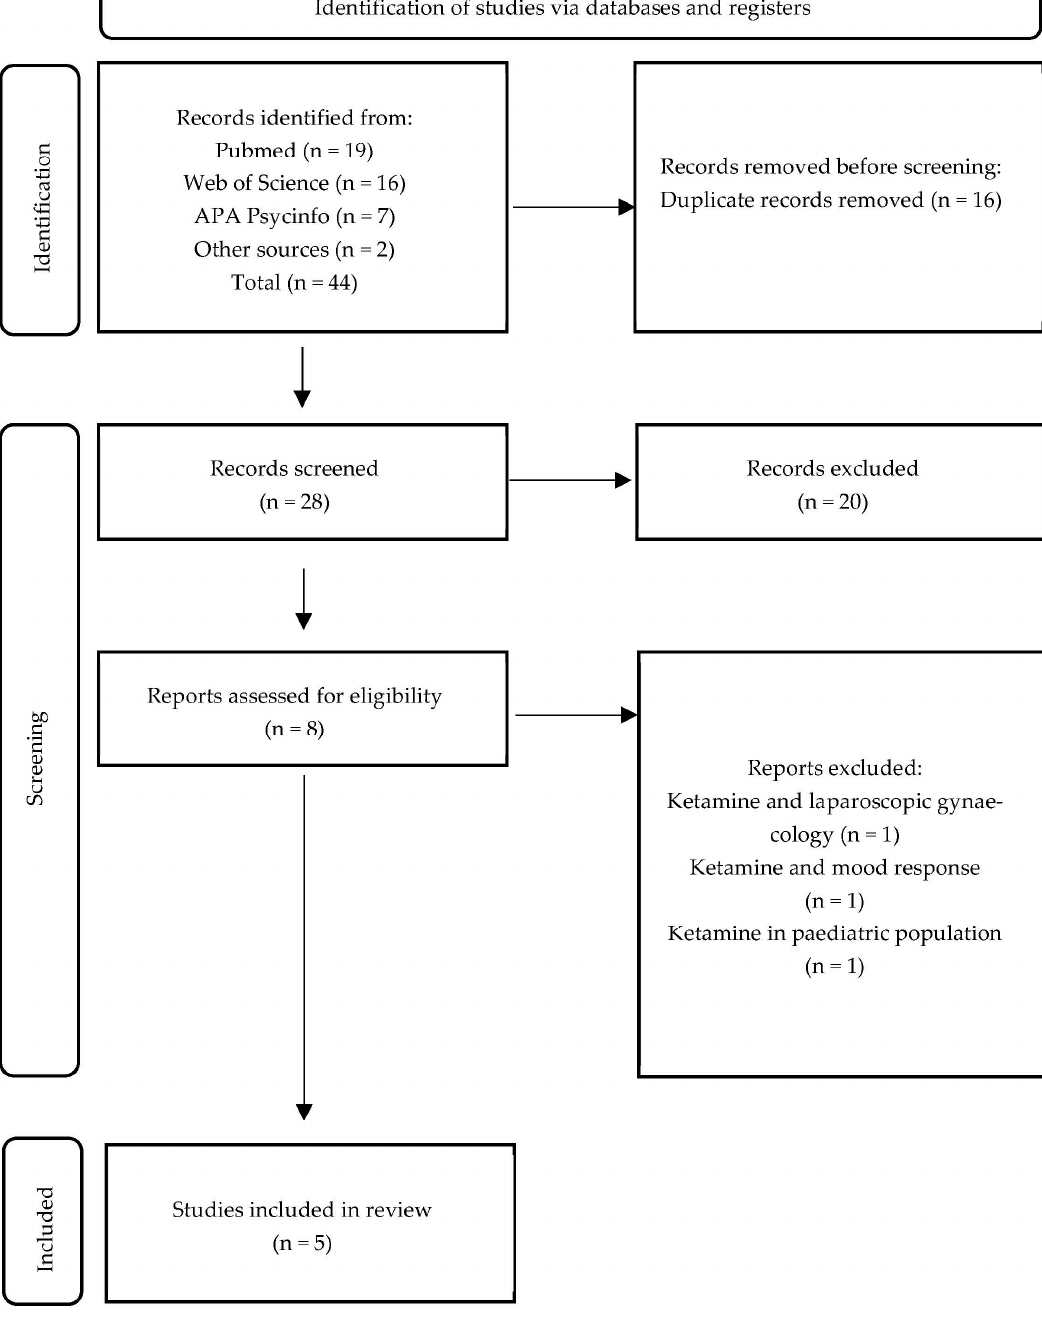
Figure 1. Flow chart representing the search strategy and the process of including studies for analysis.